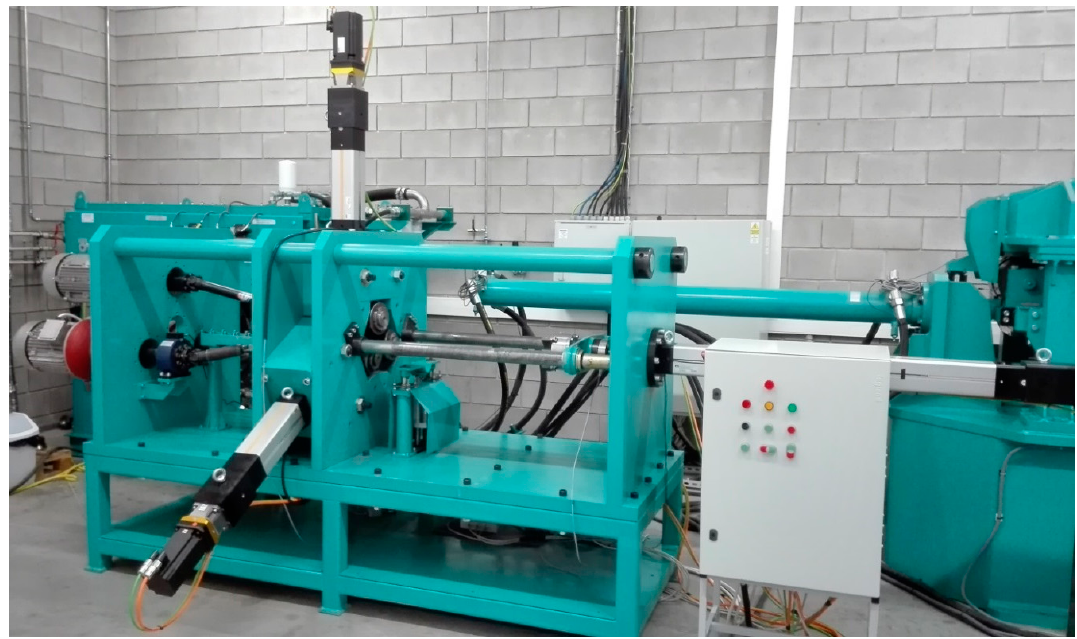
Figure 24. Laboratory CNC skew-rolling mill installed at the Lublin University of Technology.